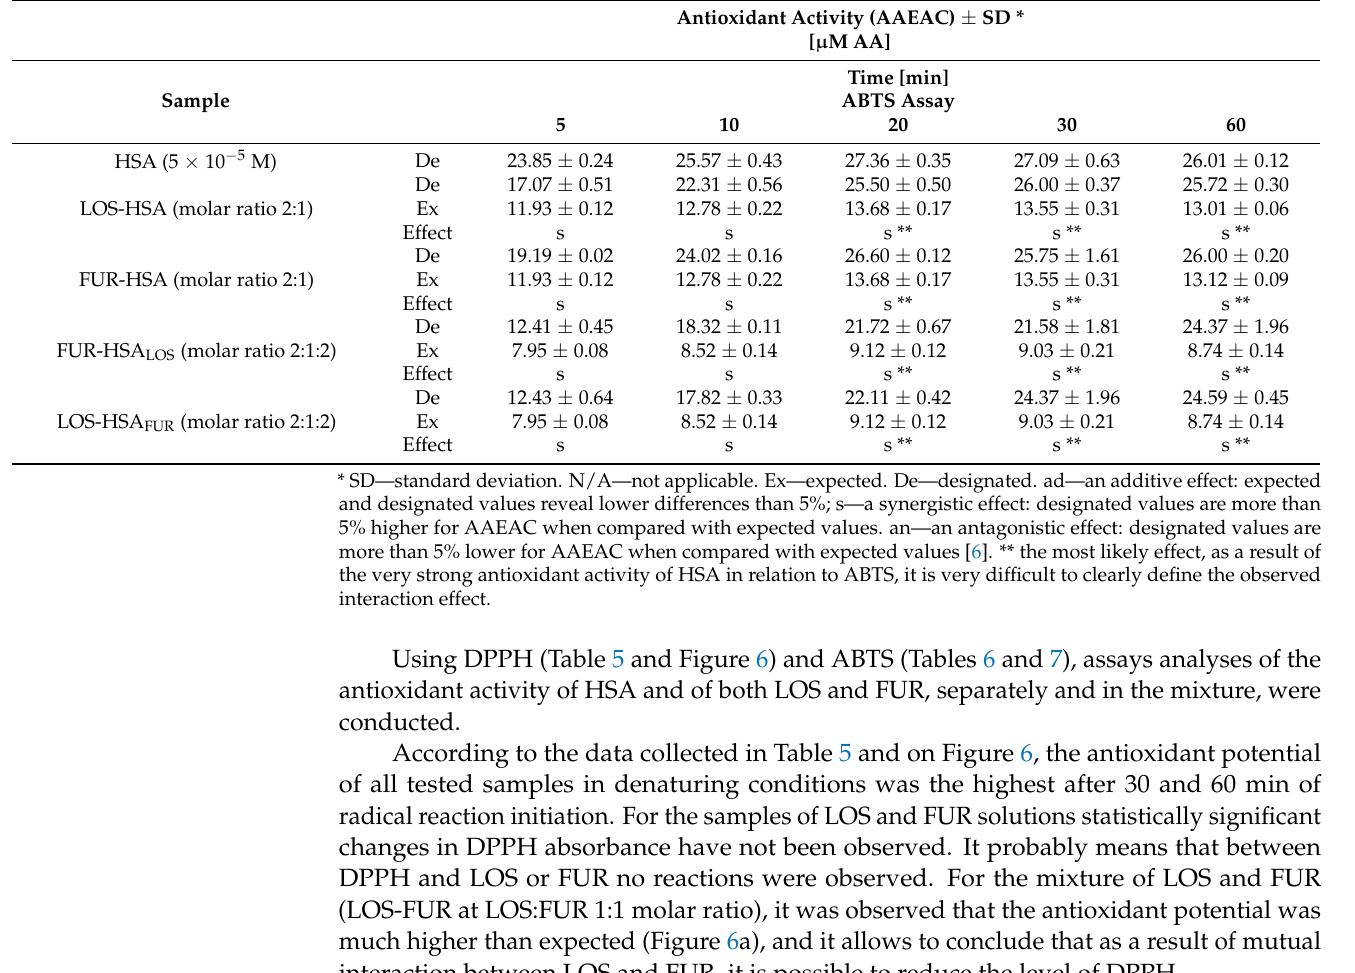
Expected versus designated values of antioxidant activity AAEAC of samples at LOS:HSA = FUR:HSA = 2:1 and LOS:FUR:HSA = FUR:LOS:HSA = 2:2:1 molar ratios (ABTS